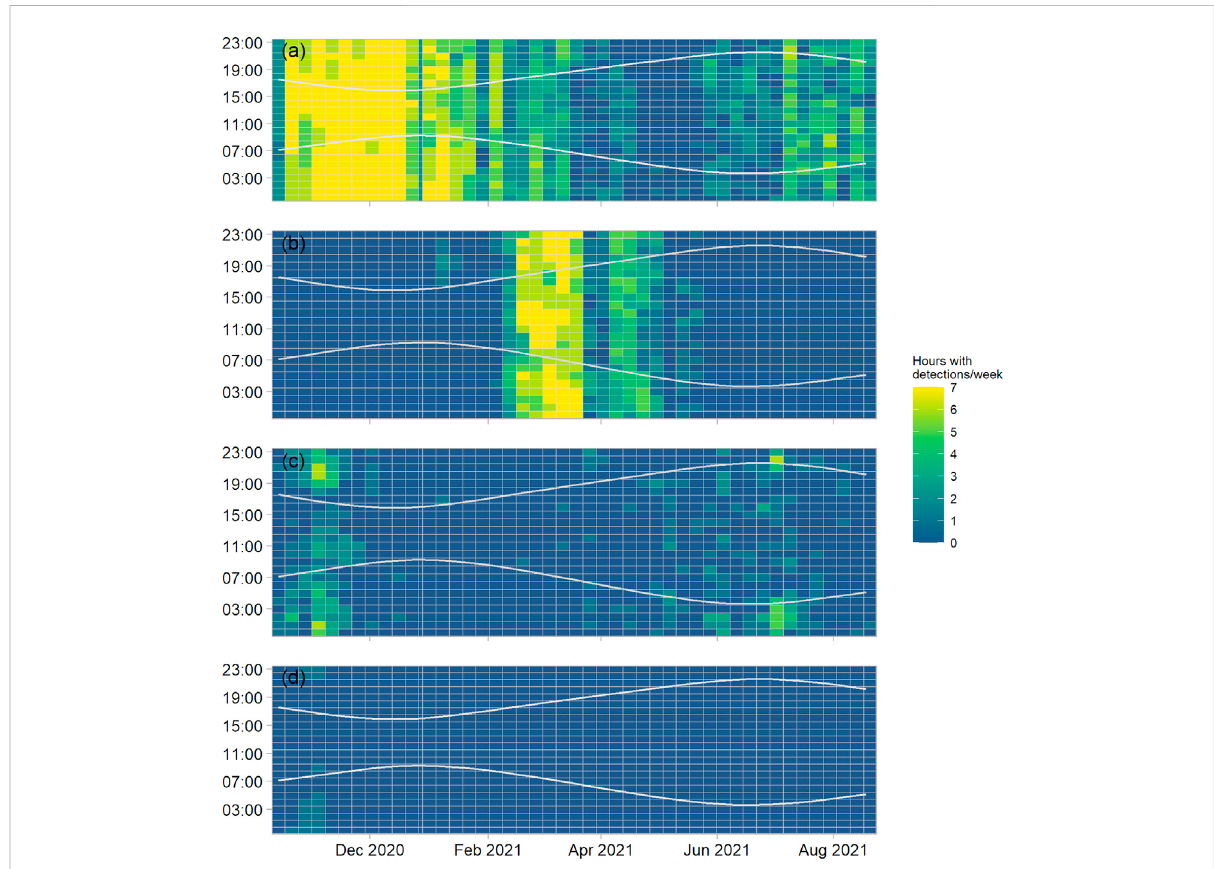
FIGURE 4 Hours with a minimum of one detection (detection positive hours) for site EL1, aggregated by week ( x -axis, tick marks indicate start of month) and plotted by hour of day ( y -axis), for (A) fi n whales (song and downsweeps), (B) humpback whale (song), (C) minke whale (song), (D) sei whale (downsweeps). The “ sun-methods ” function of the R (R Core Team, 2021) maptools (Bivand and Lewin-Koh, 2013) library was used to determine sunrise and sunset times at the site, as indicated by the grey